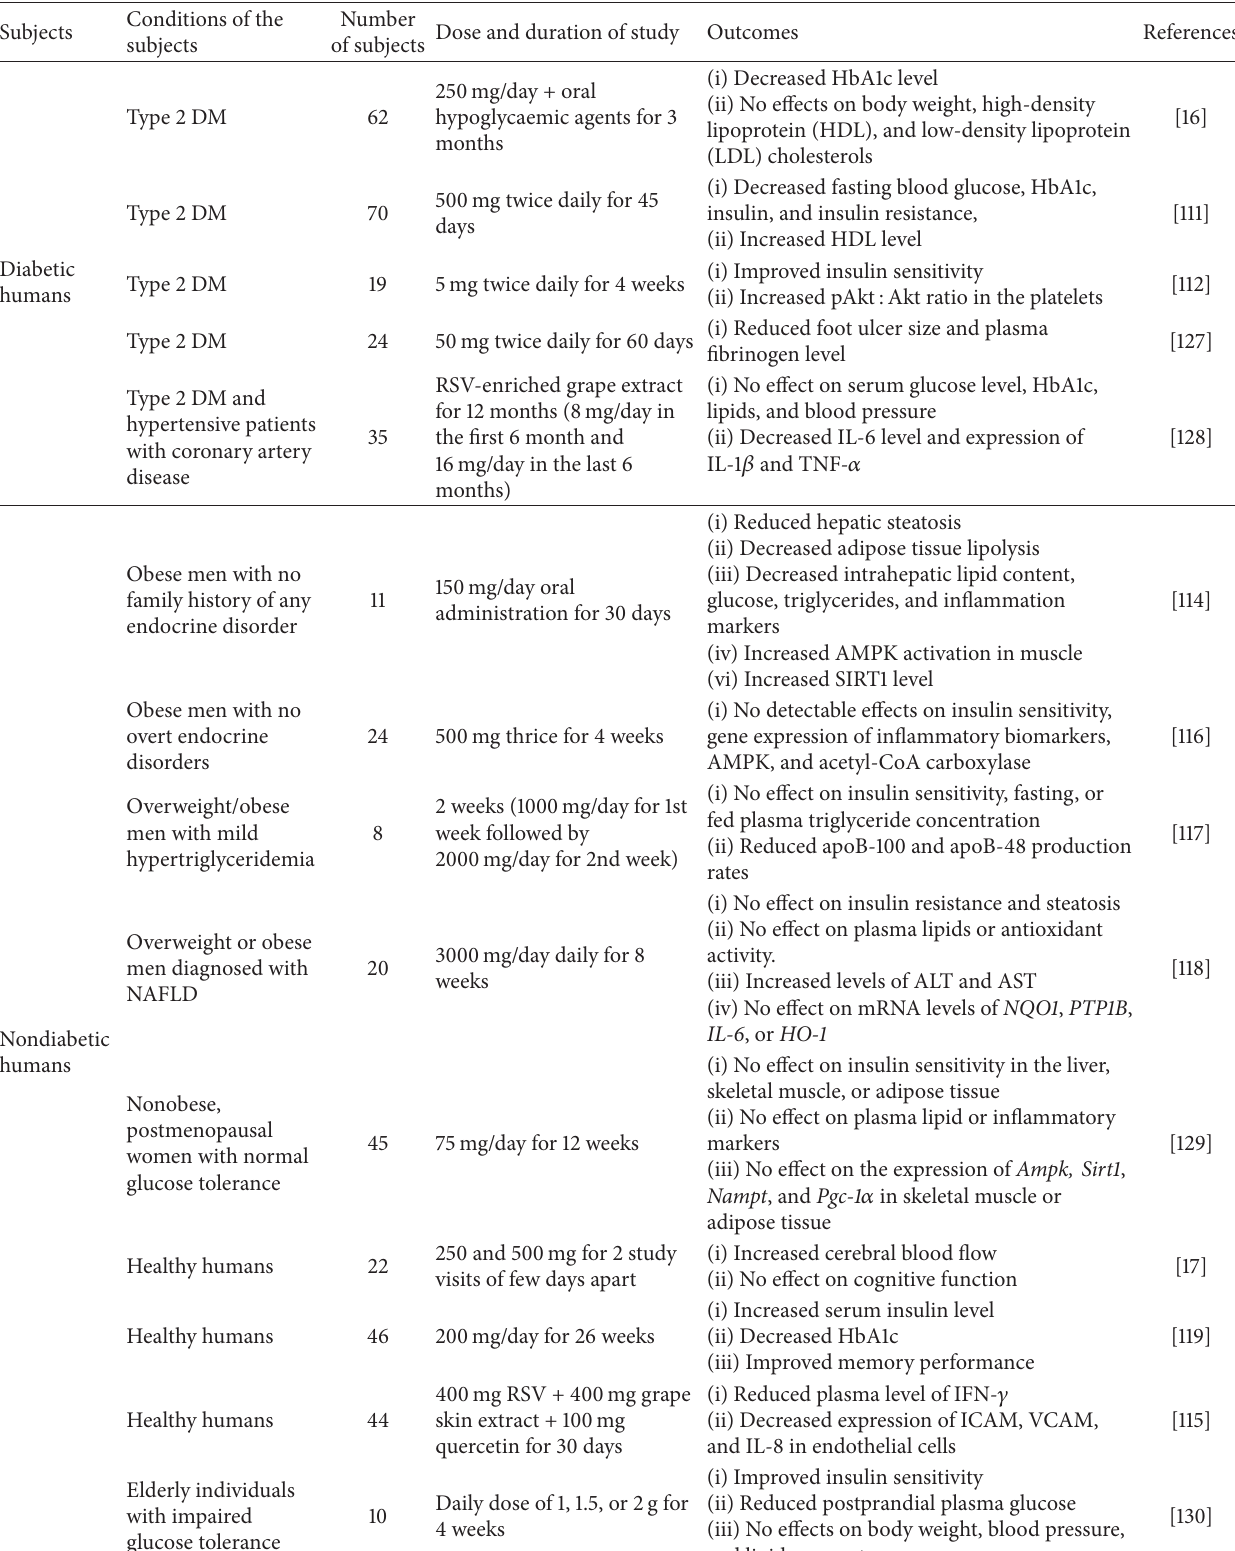
Table 2: Clinical trials on the effects of